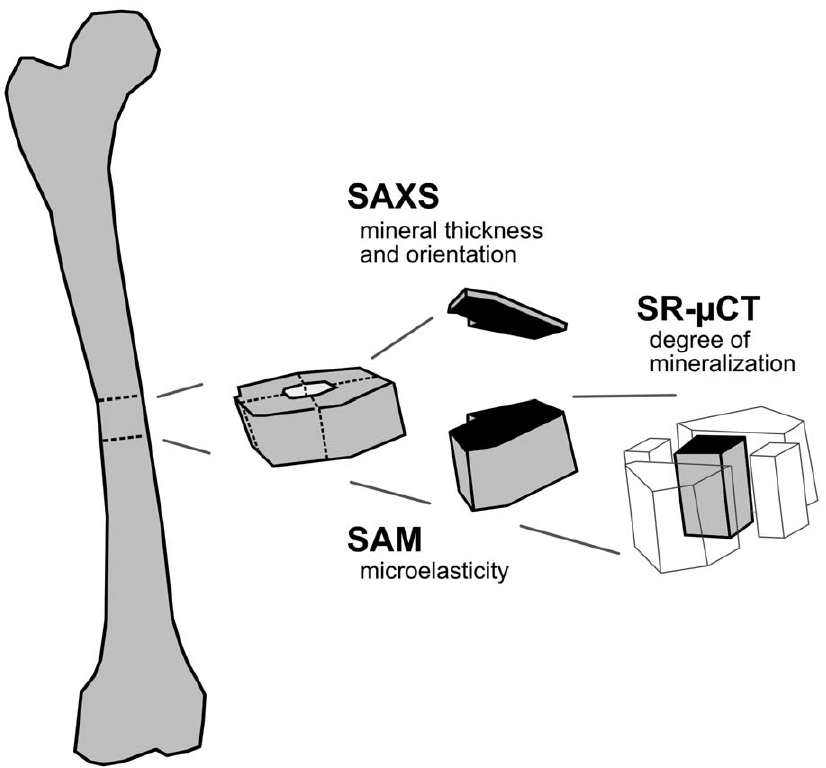
Figure 1. Sample preparation: the same surface is imaged with three high resolution techniques. A thin slice of 18 microns in thickness was cut at the surface of the sample block by microtomy to perform SAXS. A stick of 2 6 2 mm 2 which included the region scanned by SAM was cut from the block and imaged using SR- m CT.